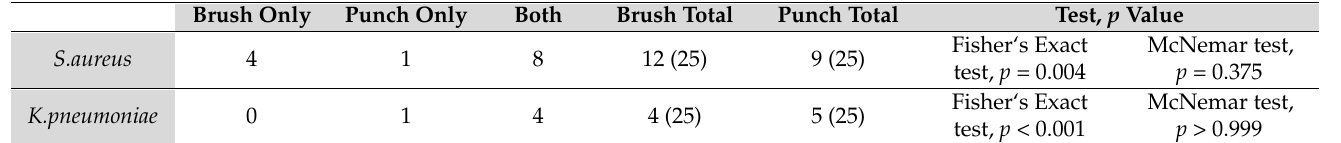
Table 1. Growth of S. aureus and K. pneumoniae from brush and punch biopsy samples.